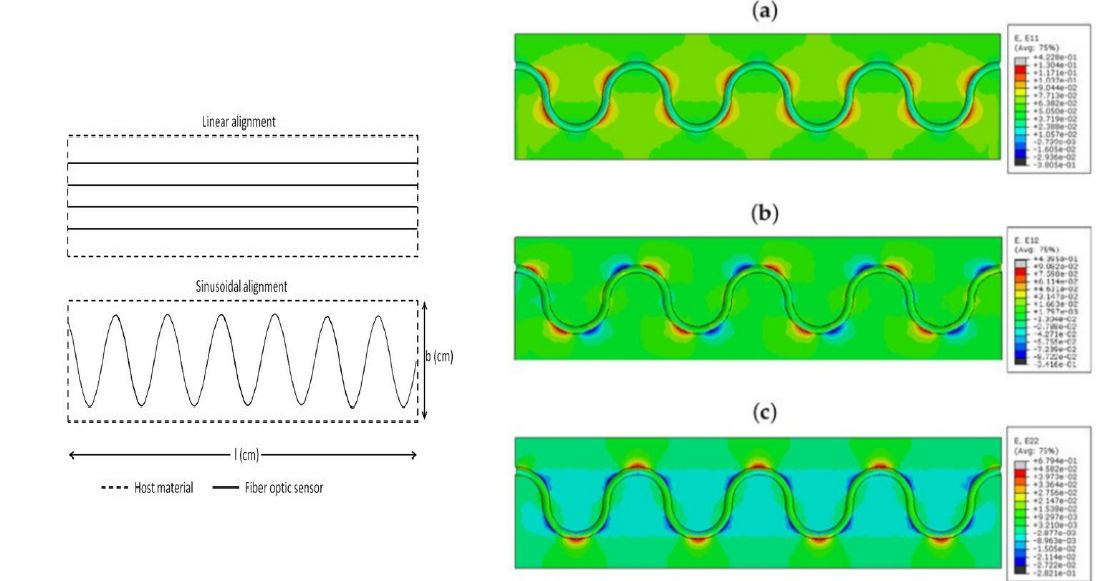
Figure 5. Illustration of linear and sinusoidal fiber FOS placement strategies: ( a ) E11 strain component; ( b ) E12 strain component; ( c ) E22 strain component (acrylate-coated FOS numerical model; the value observed in the host epoxy), sinusoidal placement. Multi-parameter strainsin linear, shear, and lateral directions) can be recorded on sinusoidal placement, while this is not shown when using straight-placed FOS.